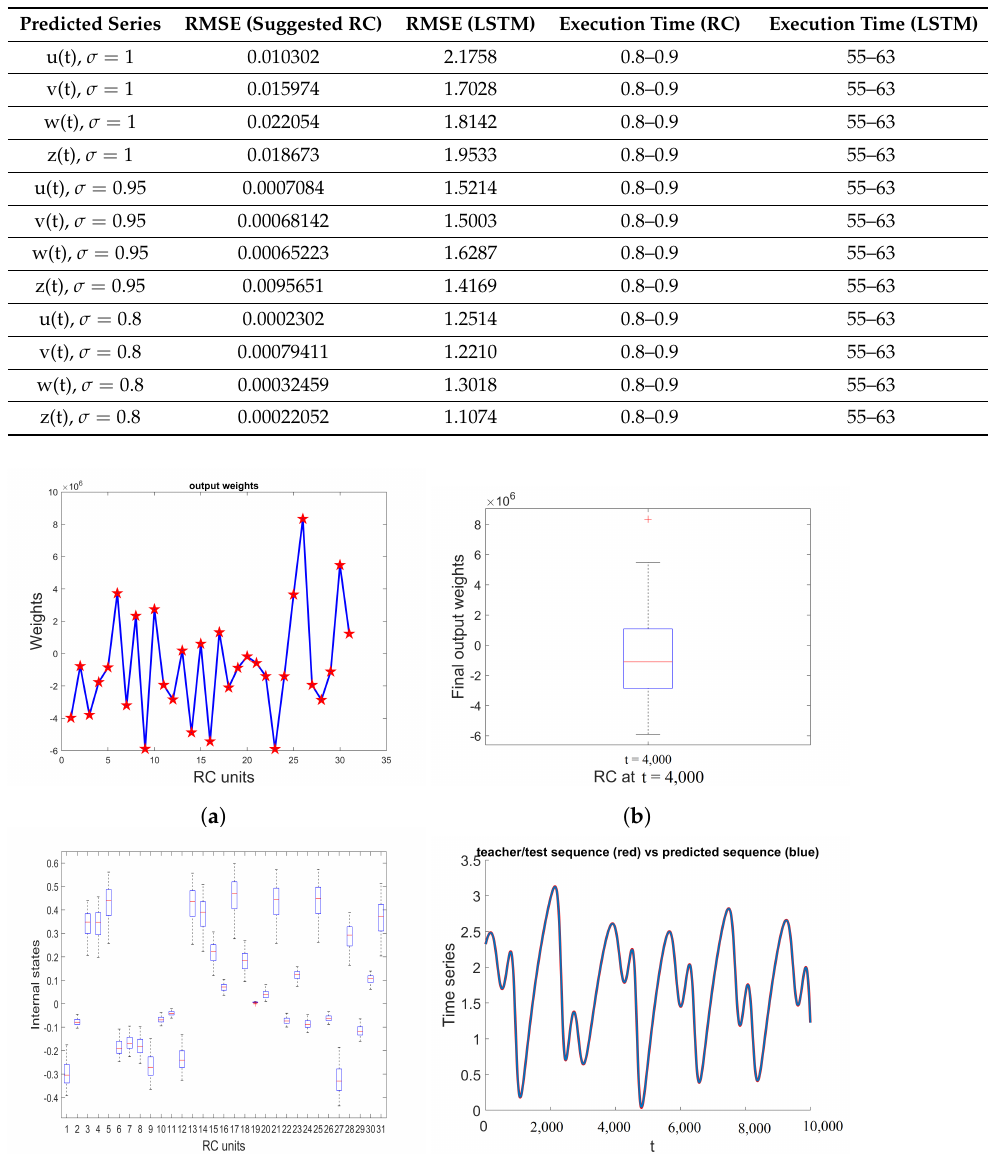
Table 1. The performance of RC forecasting scheme and LSTM approach.